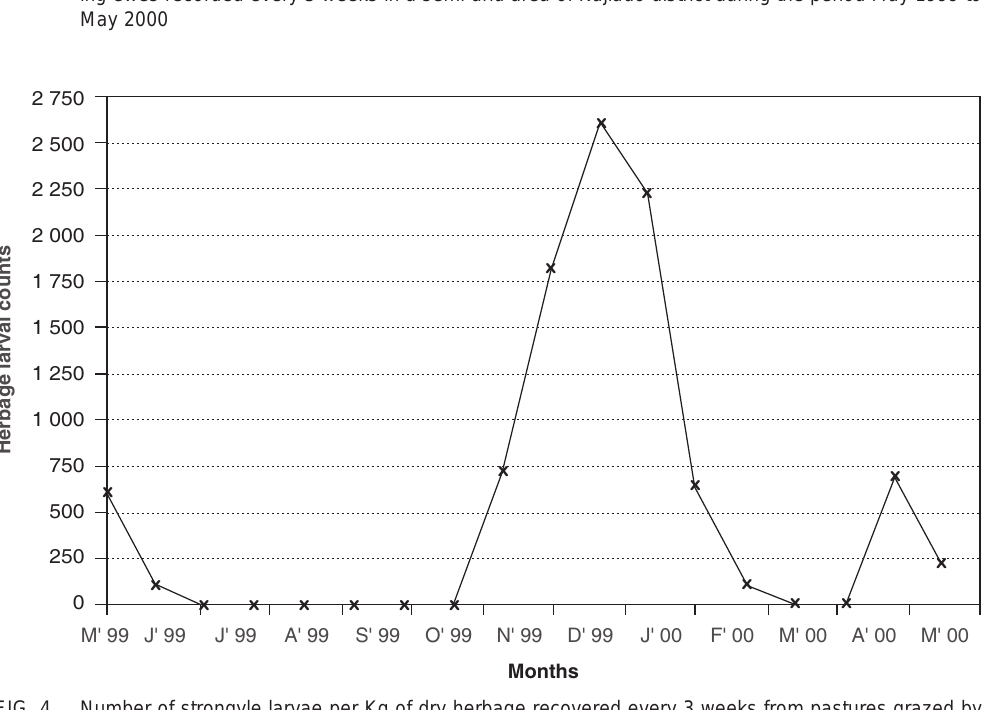
FIG. 3 Arithmetic mean strongyle eggs per gram (EPG) of faeces for Dorper lambs, yearlings and adult breed- ing ewes recorded every 3 weeks in a semi-arid area of Kajiado district during the period May 1999 to